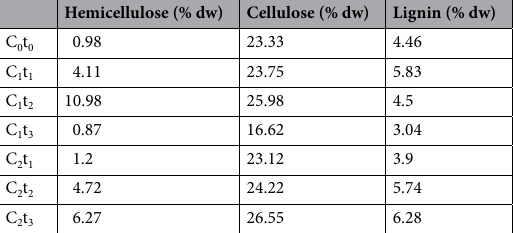
Hemicellulose (% dw) Cellulose (% dw) Lignin (%